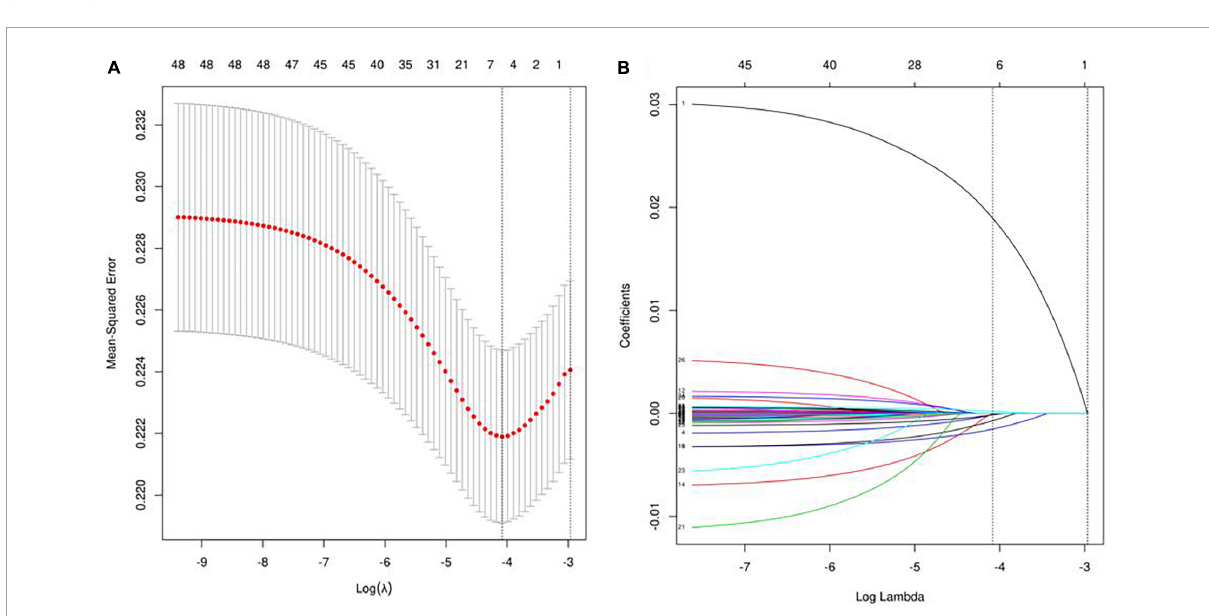
FIGURE2 Lasso regression screening of ML model predictor variables. Panel (A) shows the process of screening for the most appropriate λ in the lasso model; panel (B) shows the lasso coefficient curves for the 48